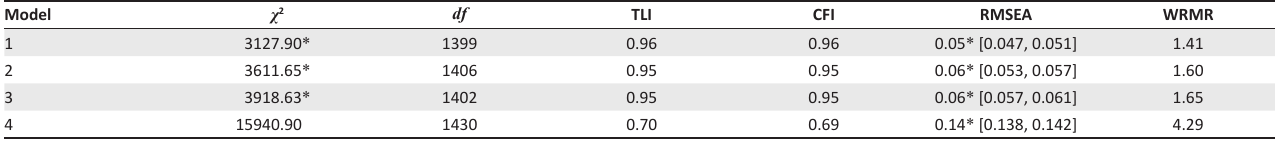
Table 2: Fit statistics of competing measurement models ( N = 513).